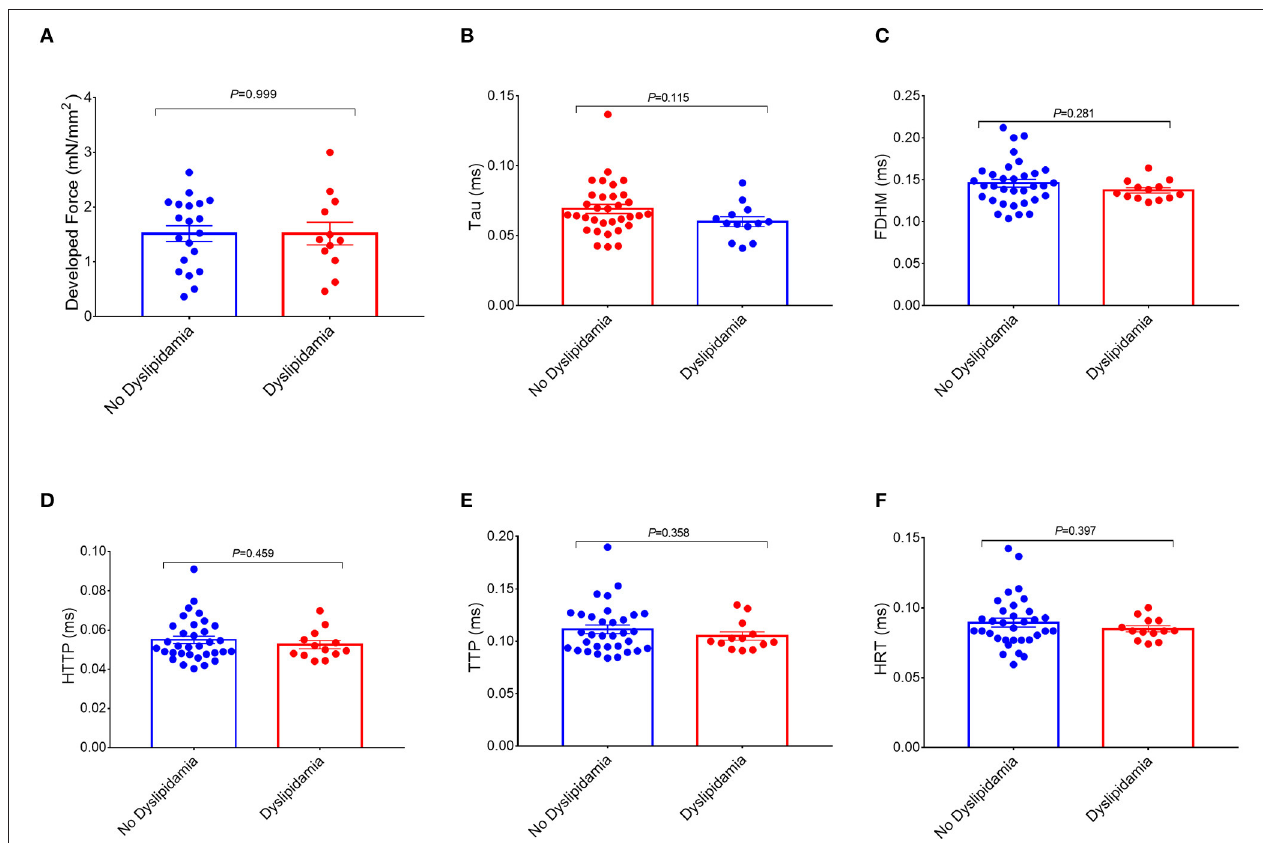
FIGURE 3 | Comparisons of the measurements of the right atrial trabeculae function between the dyslipidemia group and the no dyslipidemia group. The developed force of the right atrial trabeculae of 32 patients (dyslipidemia group: n = 12; no dyslipidemia group: n = 20) was analyzed (A) and the rest of the parameters of the right atrial trabeculae of 46 patients (dyslipidemia group: n = 13; no dyslipidemia group: n = 33) was analyzed (B–F) . There is no significant difference in the measurements of the right atrial trabeculae function between the two groups. Data are expressed as mean ± SEM. BMI, body mass index; HTTP, half time to peak; TTP, time to peak; FDHM, full duration at half maximum; HRT, half relaxation time; Tau, relaxation time